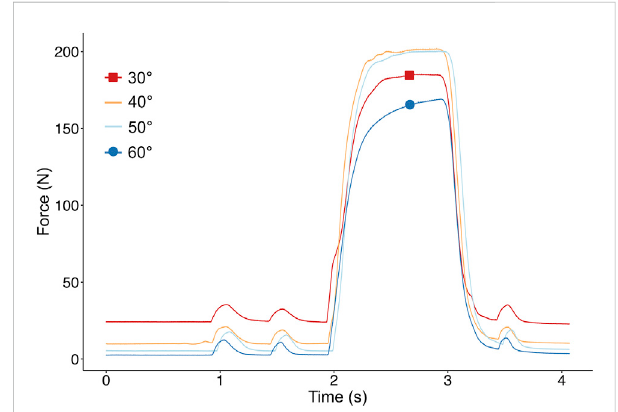
FIGURE 2 Example of superimposed force-time traces collected from the Achilles Tendon of one patient at different ankle angles. After two pulsatile stimulations, the muscle is stimulated supramaximally to reach a tetanic plateau and the maximal muscle force.